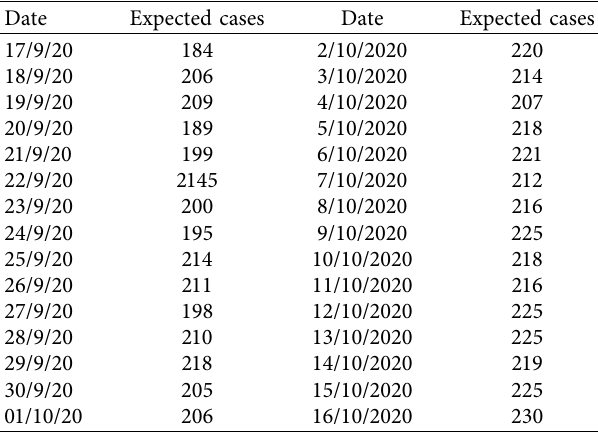
Table 6: The prediction results of daily confirmed COVID-19 cases in West Africa for the next month as predicted by the ARIMA (2,1,3) model.